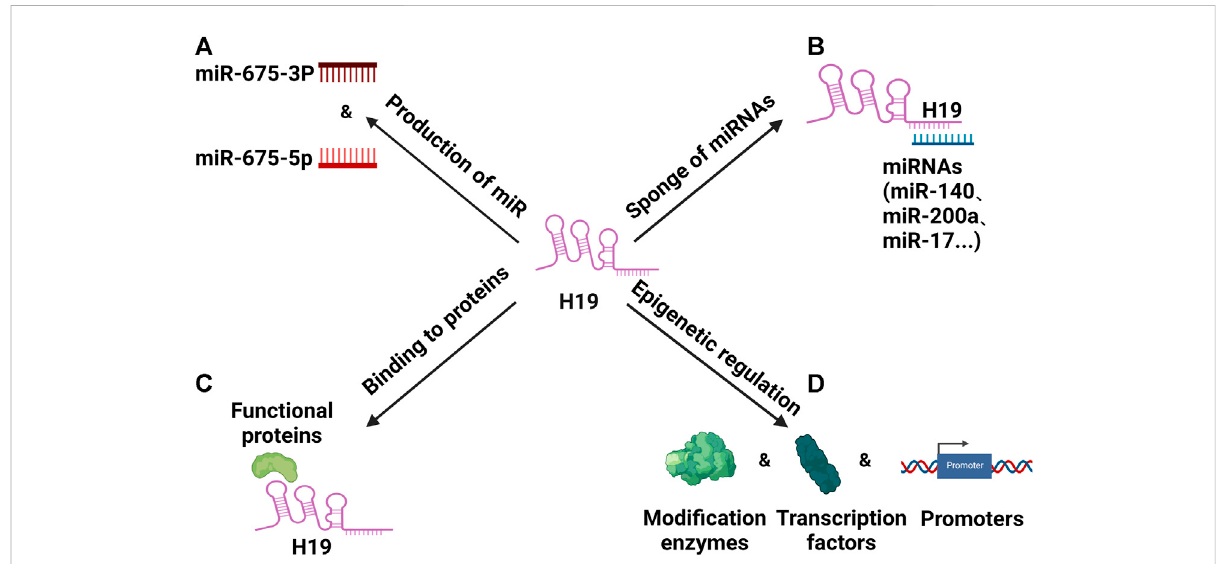
FIGURE 1 TheregulatoryrolesofH19. (A) H19canindirectlyregulatesdownstreammoleculesbyitsspliceosomemiR-675-3pormiR-675-5p. (B) H19can regulatesdownstreammoleculesbyactingasa “ miRNAsponge ” . (C) H19canregulatesdownstreammoleculesbybindingtofunctionalproteins. (D) Byepigeneticpathways,H19canregulatemodi fi cationenzymes,transcriptionfactorsandpromoterstoregulatedownstreammolecularexpression.